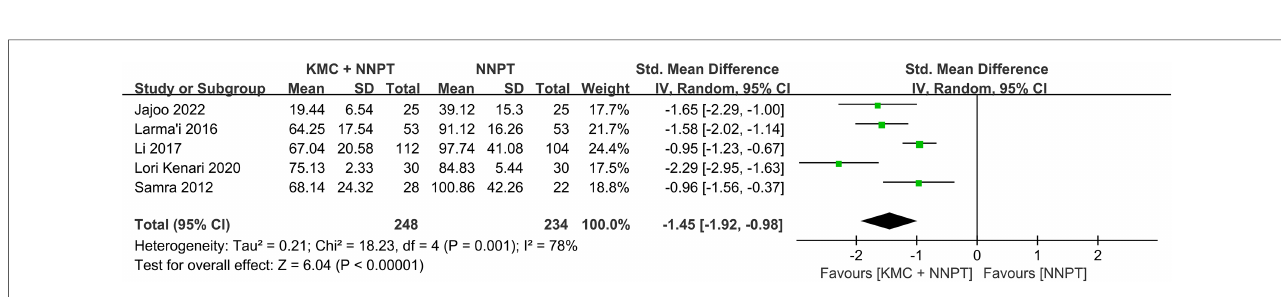
FIGURE 4 Forest plot comparing KMC+NNPT with NNPT alone on the duration of phototherapy in neonates with non-pathological jaundice.